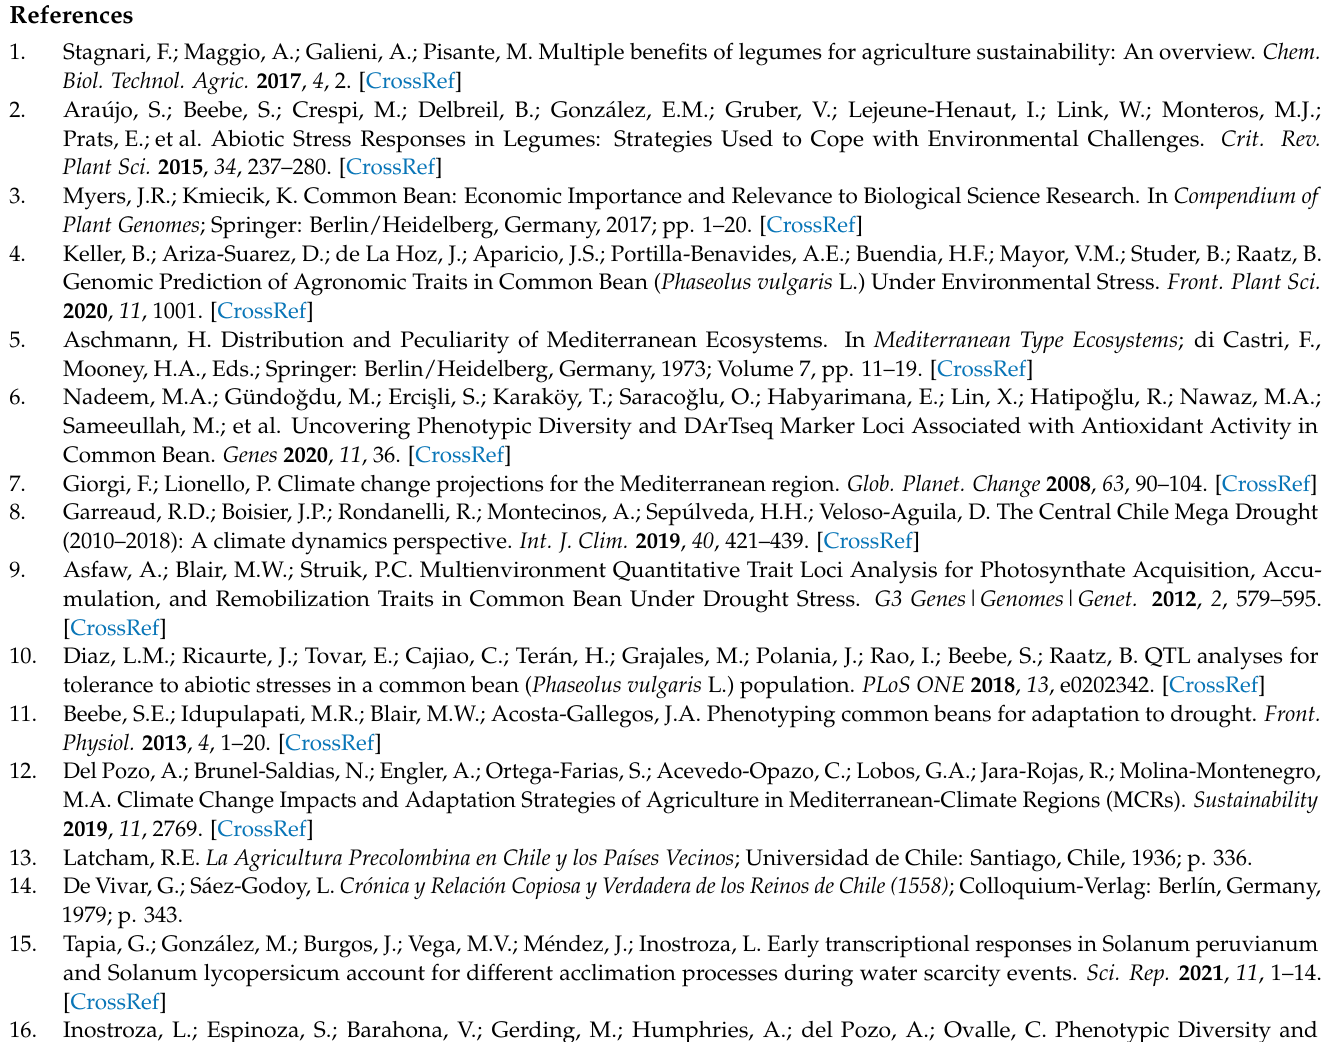
Table S1: Chilean landraces information; Table S2: Drought tolerance categorizing of common bean Chilean